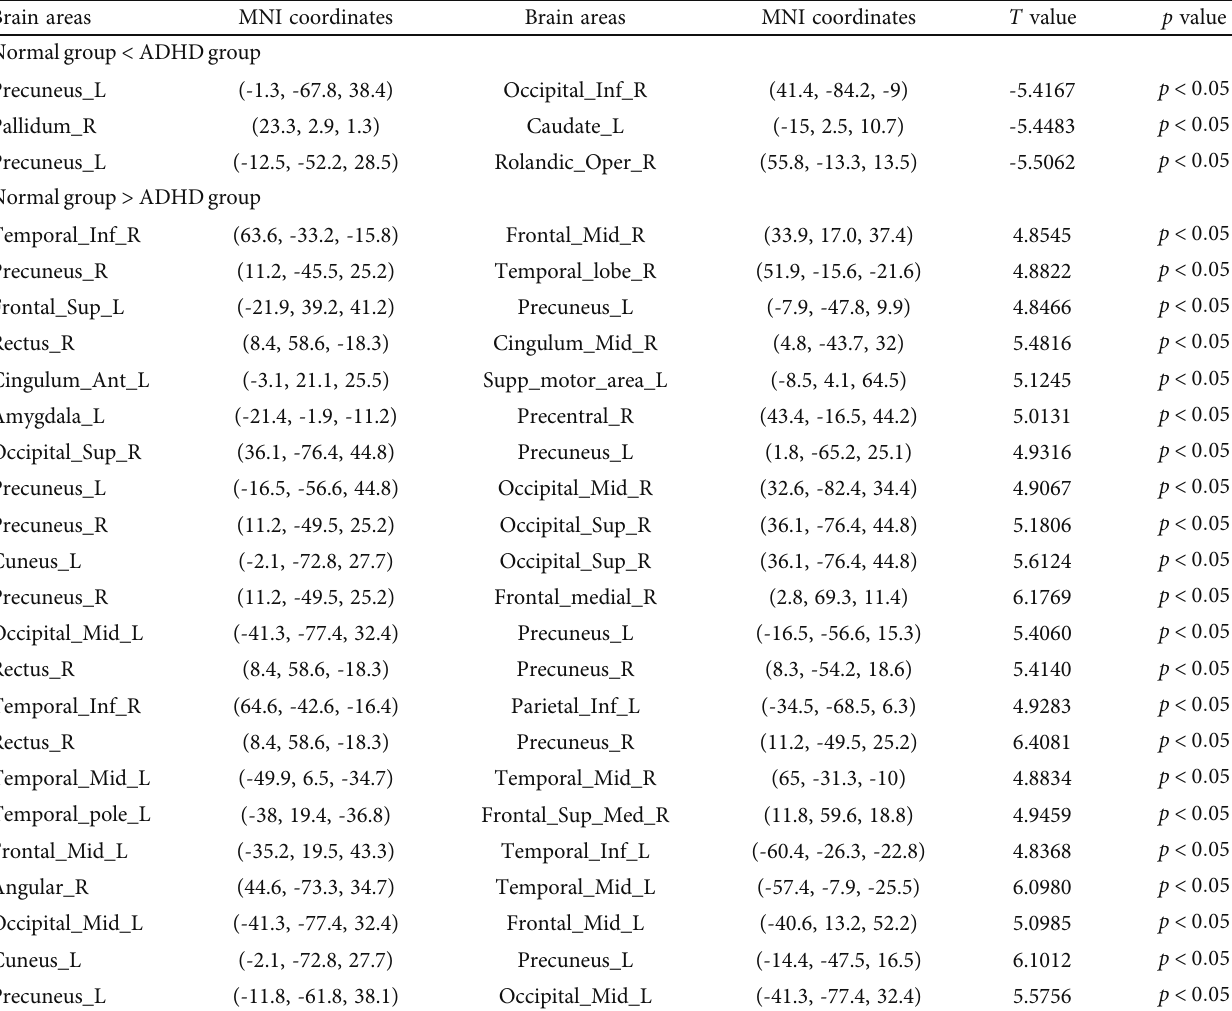
Figure 5: The di ff erential edges between two groups: (a) the weakened edges of the ADHD group compared to the normal group; (b) the enhanced edges of the ADHD compared to the normal group. Table 4: Di ff erential edge